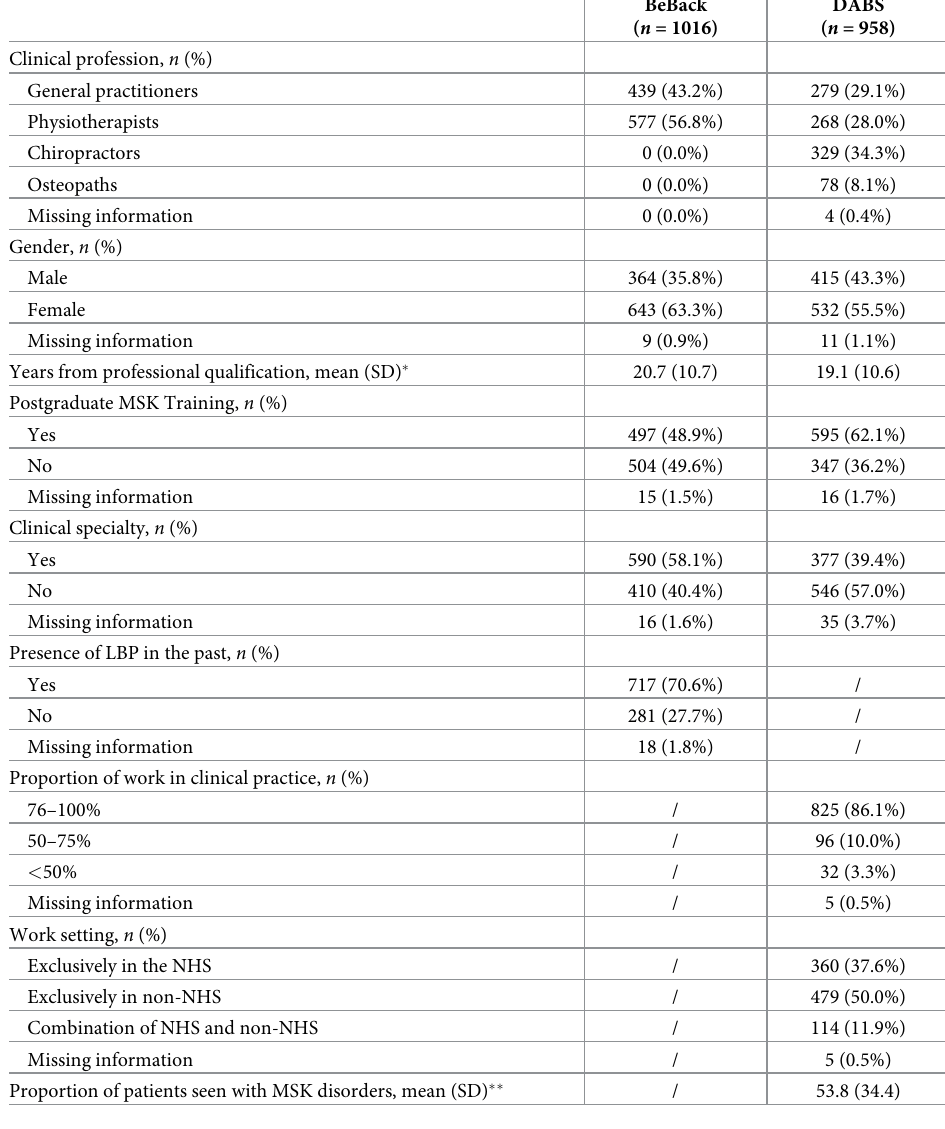
Table 1. Socio-demographic characteristics of health care professionals included in the two samples used in this study.